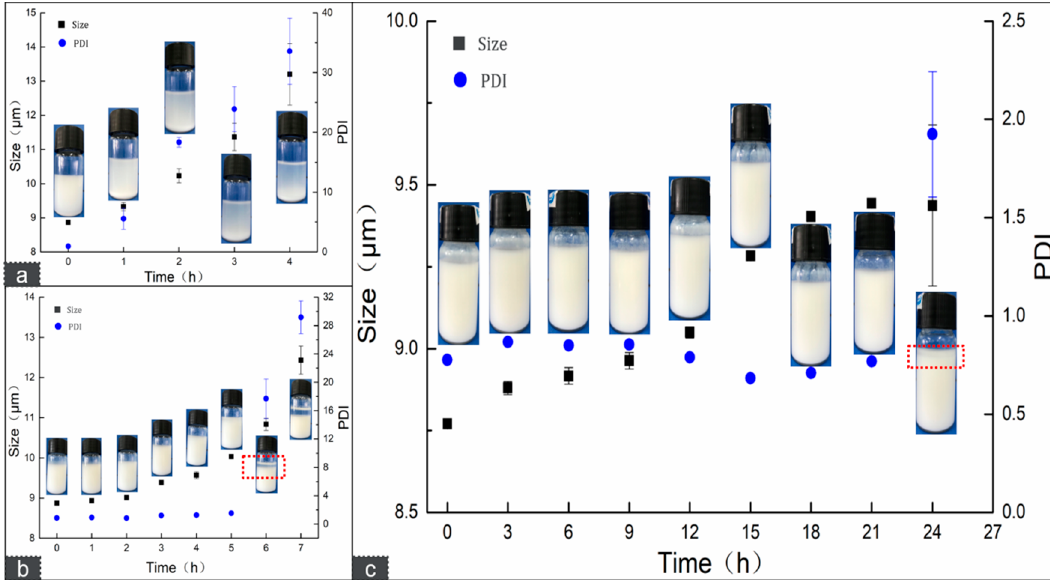
Figure 8. Variation of particle size and PDI of Pickering emulsion of organic mesoporous silica with different concentrations over time. The concentrations in Figure ( a – c ) were 1%, 10% and 20%, respectively.